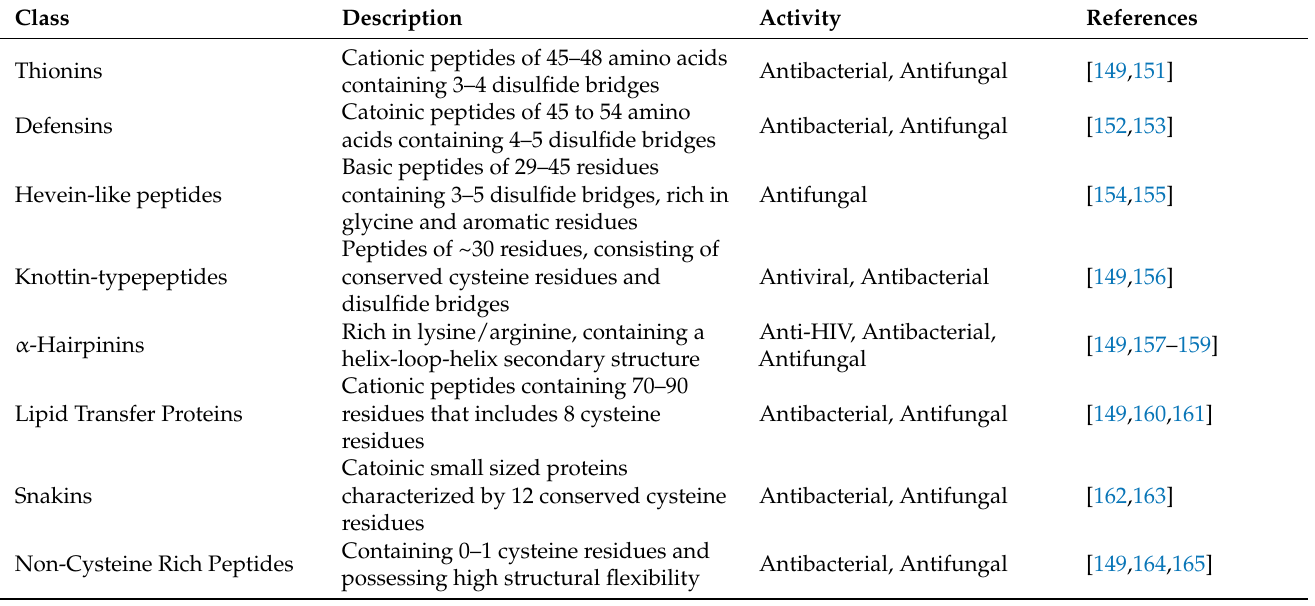
Table 1. Classification of Plant